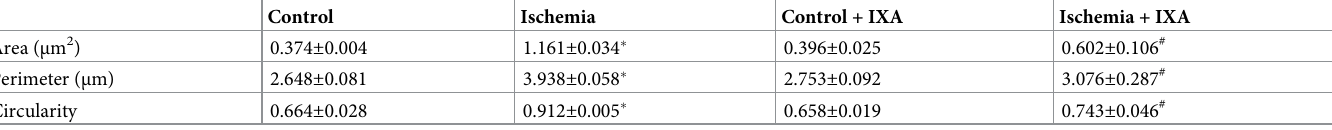
Table 1. Mitochondrial morphological